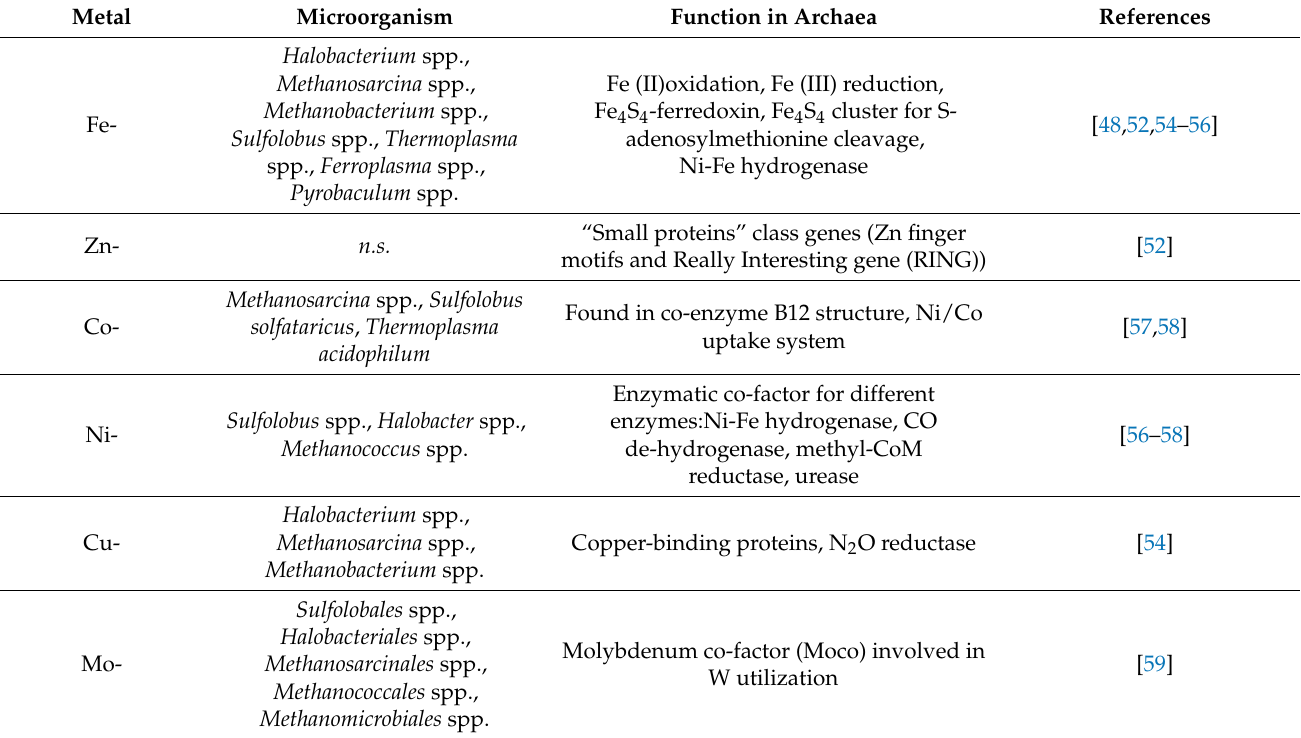
Table 1. Physiological role of essential metals in some selected species of